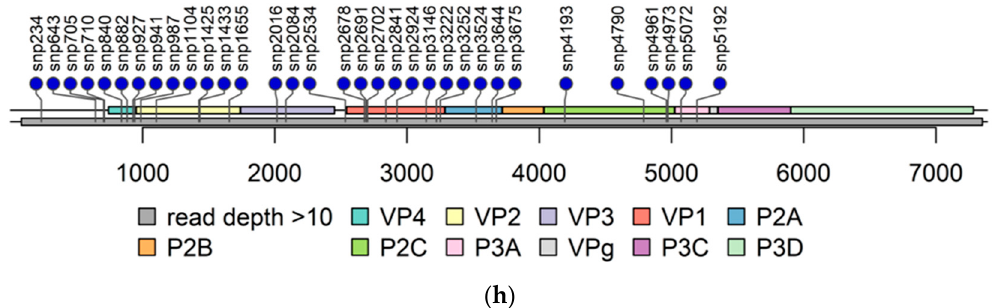
Figure 4. Lolliplots of each PIDV at the last timepoint. Single nucleotide polymorphism (SNP) are indicated by lollipop. All non-synonymous SNPs, and SNPs at both UTR are indicated. Grey bar below the genome bar characterizes the read depth (>10). ( a ) ATCC E1-PIDV [PANC-1] . ( b ) ATCC E2-PIDV [PANC-1] . ( c ) 10796-PIDV [PANC-1] . ( d ) 10797-PIDV [PANC-1] . ( e ) 10802-PIDV [PANC-1] . ( f ) ATCC-PIDV [1.1B4] .